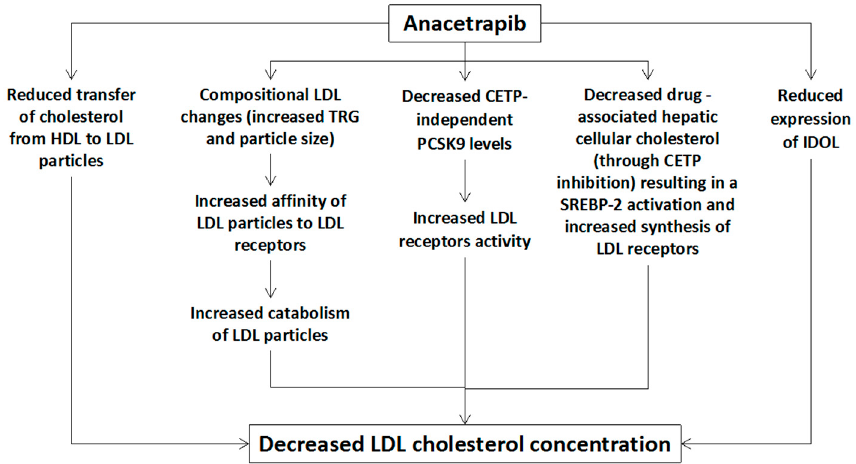
Figure 1. Potential mechanisms of anacetrapib-mediated reduction of low-density lipoprotein (LDL) cholesterol. HDL: high-density lipoprotein, LDL: low-density lipoprotein, CETP: cholesteryl ester transfer protein, TRG: triglycerides, SREBP: sterol regulatory element binding protein, IDOL: inducible degrader of the low-density lipoprotein receptor, PCSK9: proprotein convertase subtilisin/kexin type 9.